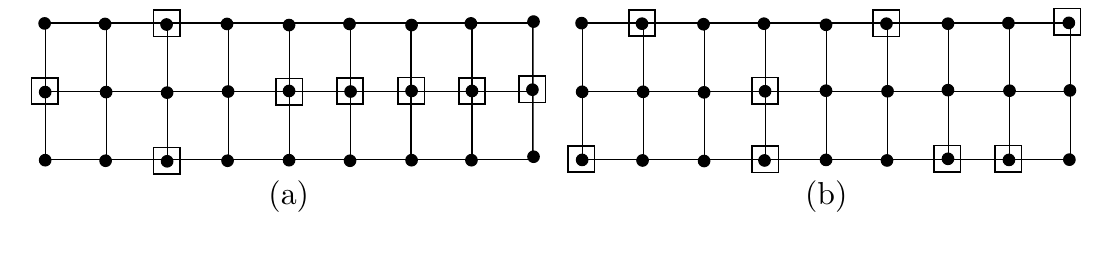
Figure 15: Dominating sets of P